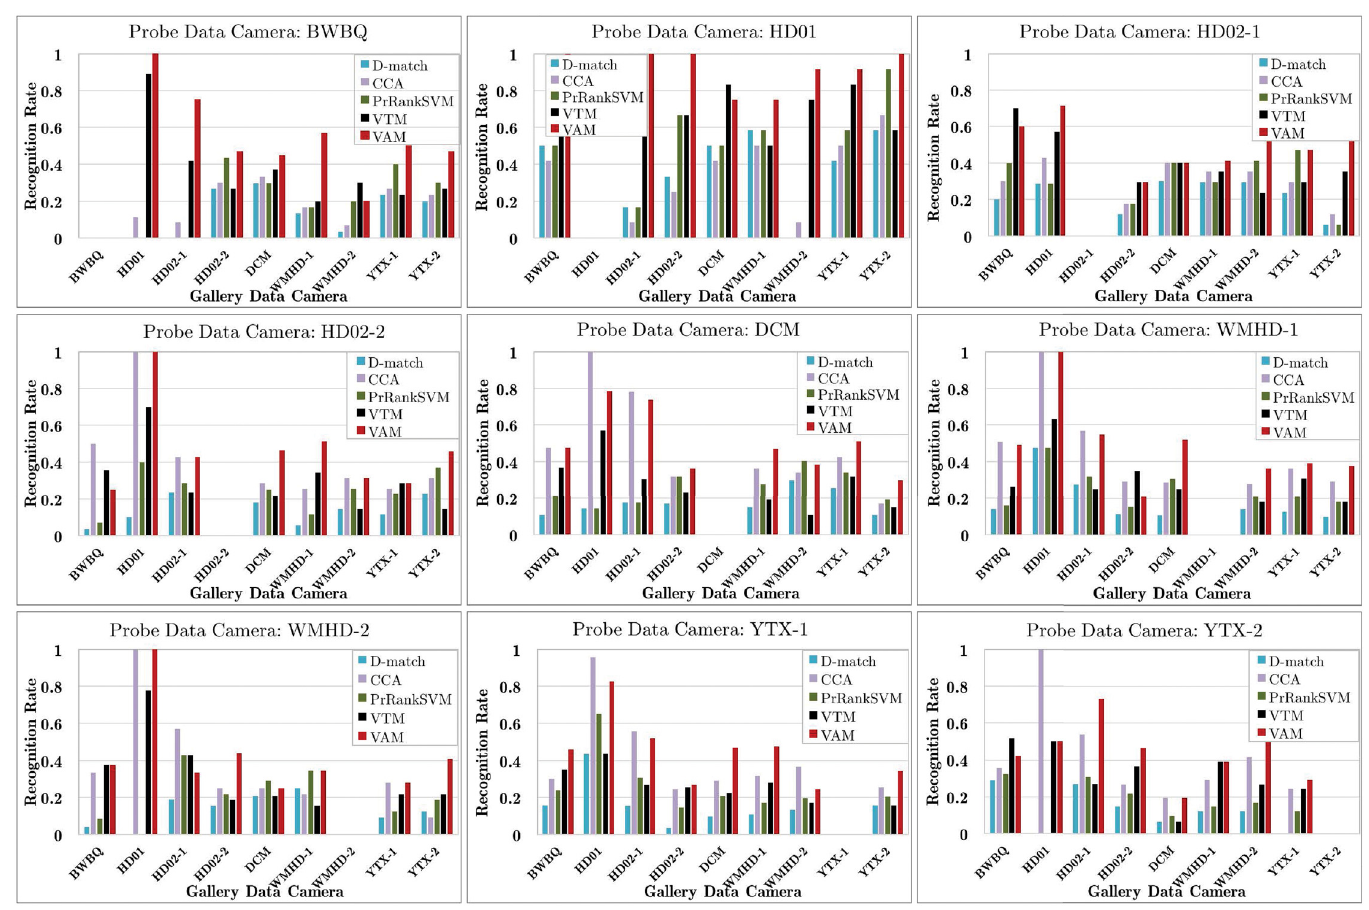
Fig 11. Results of free-view gait recognition on the PKU